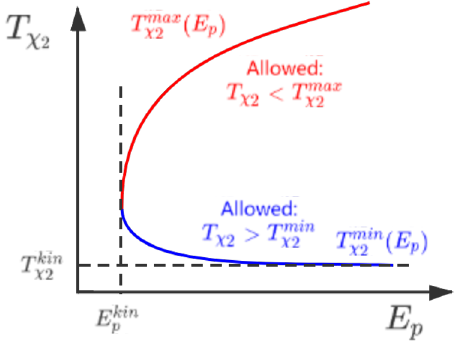
. From eq. (A.7), the red curve 2 with θ ∗ = 0 . The kinetic allowed χ 2 = δ 2 χ 2 2 m χ 1